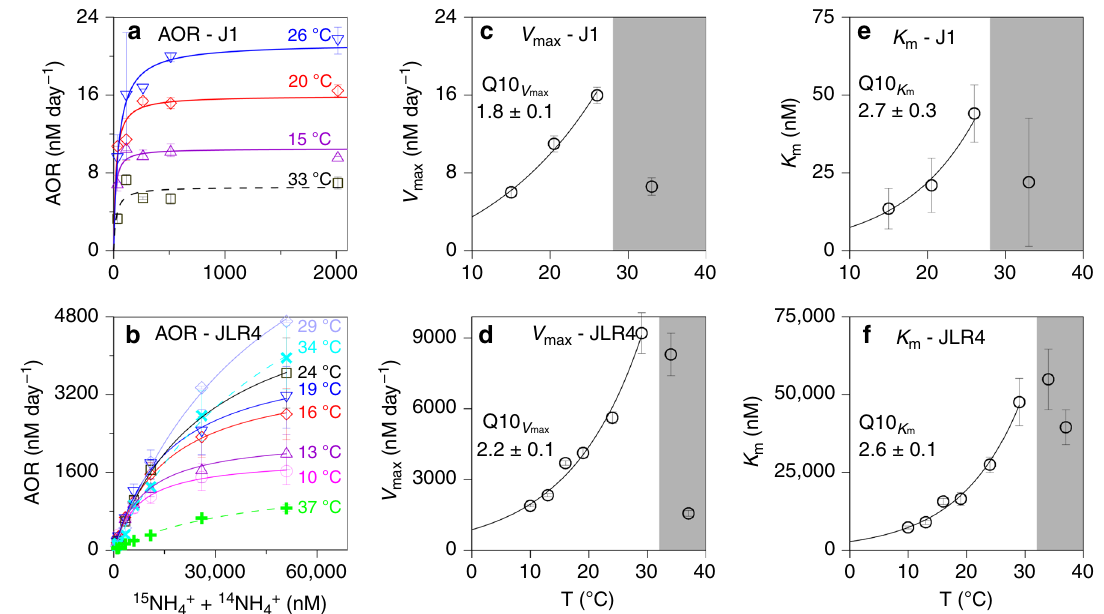
Fig. 2 Thermal kinetics plots for ammonia oxidation rates. a , b Michaelis – Menten kinetics of ammonia oxidation rates in response to changes in temperature. c – f Arrhenius model fi tting curves for the experimental V max (J1: Y = (4.1 ± 0.7) × (1.8 ± 0.1) T/10 , R 2 = 0.99; JLR4: Y = (869.9 ± 118.2) × (2.2 ± 0.1) T/10 , R 2 = 0.98) and K m (J1: Y = (2.6 ± 1.1) × (2.7 ± 0.3) T/10 , R 2 = 0.98; JLR4: Y = (2765.7 ± 404.6) × (2.6 ± 0.1) T/10 , R 2 = 0.99) of the ammonia oxidation rate as a function of temperature. Color curves in ( a , b ) represent the regression curves of the Michaelis – Menten kinetics at various temperatures. Fitting curves in ( c – f ) are for data points lower than the optimum temperature in substrate-saturated conditions ( T opt-sat , ~26 °C for station J1; ~29 °C for station JLR4). Solid lines in ( a , b ) and the white areas in ( c – f ) represent the Michaelis – Menten kinetics at temperatures lower than the T opt-sat . While dotted lines in ( a , b ) and the gray areas in ( c – f ) represent the Michaelis – Menten kinetics at temperatures greater than the T opt-sat . See Supplementary Table 2 for more details on the temperature dependence of K m and V max . The data in ( a ) are presented as mean values, instead of standard deviation the given bars indicate the variation range of two independent experiments. Data in ( b – f ) are expressed as the mean values ± SD ( n = 6 in ( b ); n = 10 in ( c , e ); n = 48 in ( d , f ); independent